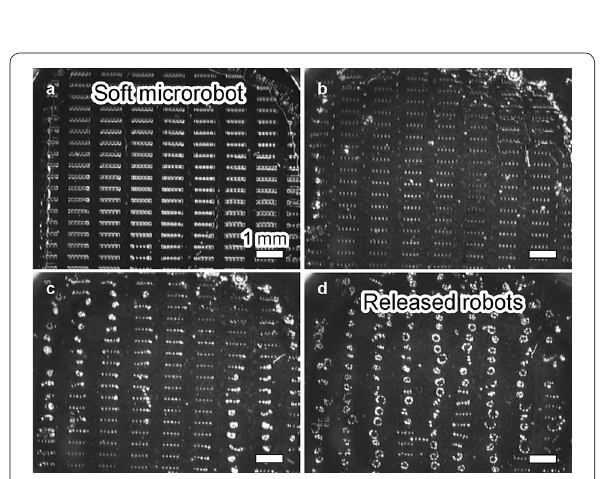
Fig. 8 Mass production and release of soft microrobot. a Before immersion in water, and b – d after immersion in water